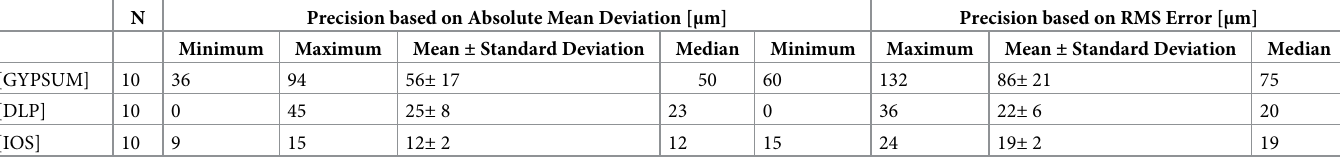
Table 2. Precision